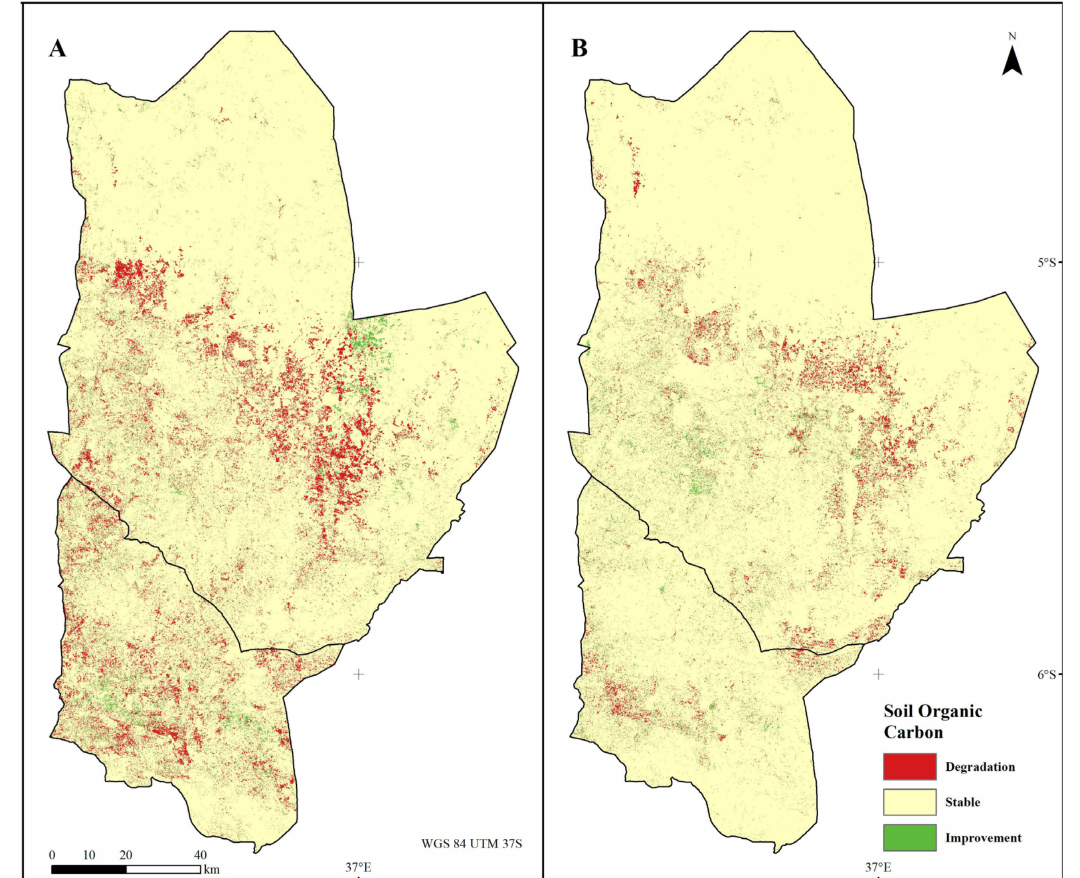
Figure 6. The soil organic carbon sub-indicator generated using the adapted approach with SoilGrids250m for the ( A ) baseline and ( B ) monitoring period.